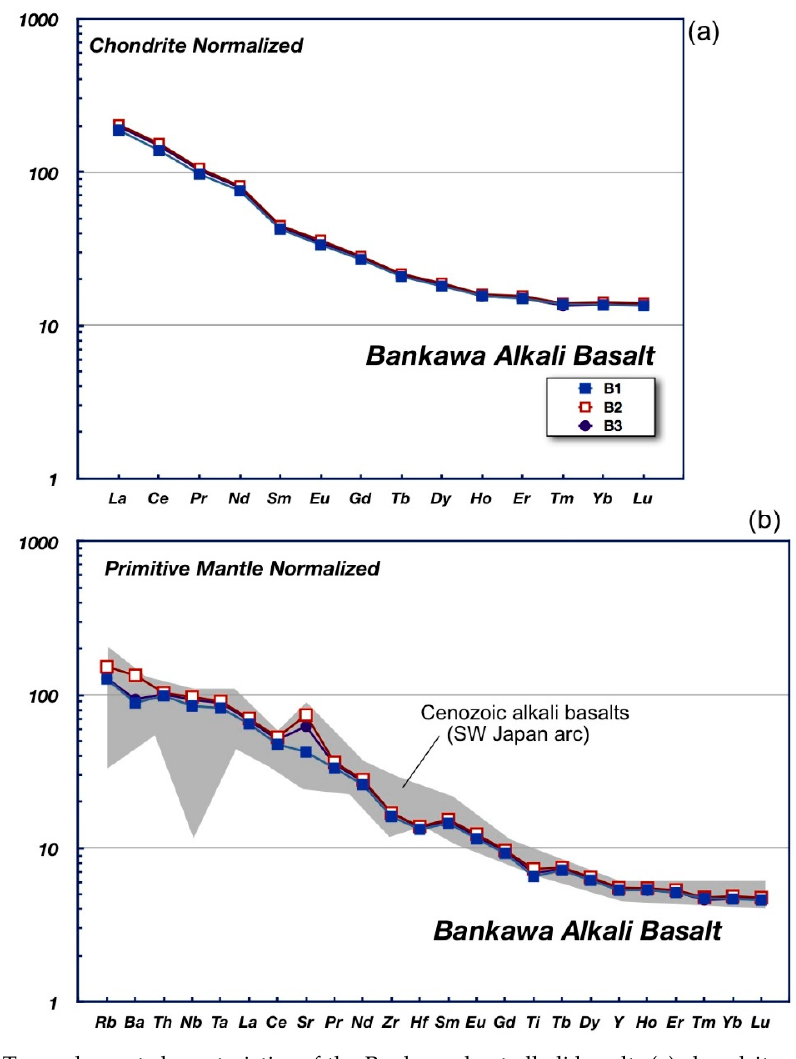
Figure 5. Trace-element characteristics of the Bankawa host alkali basalt. ( a ) chondrite-normalized REE pattern; ( b ) primitive mantle normalized trace-element pattern. Three samples (B1, B2 and B3) were analyzed. Range of Cenozoic alkali basalts from the SW Japan arc [54] are shown for comparison. Normalized values are from Sun and McDonough [65].